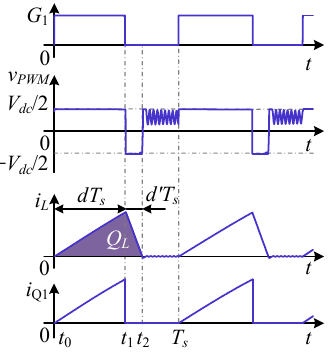
Figure 3. The DCM operation waveforms of the inverter.